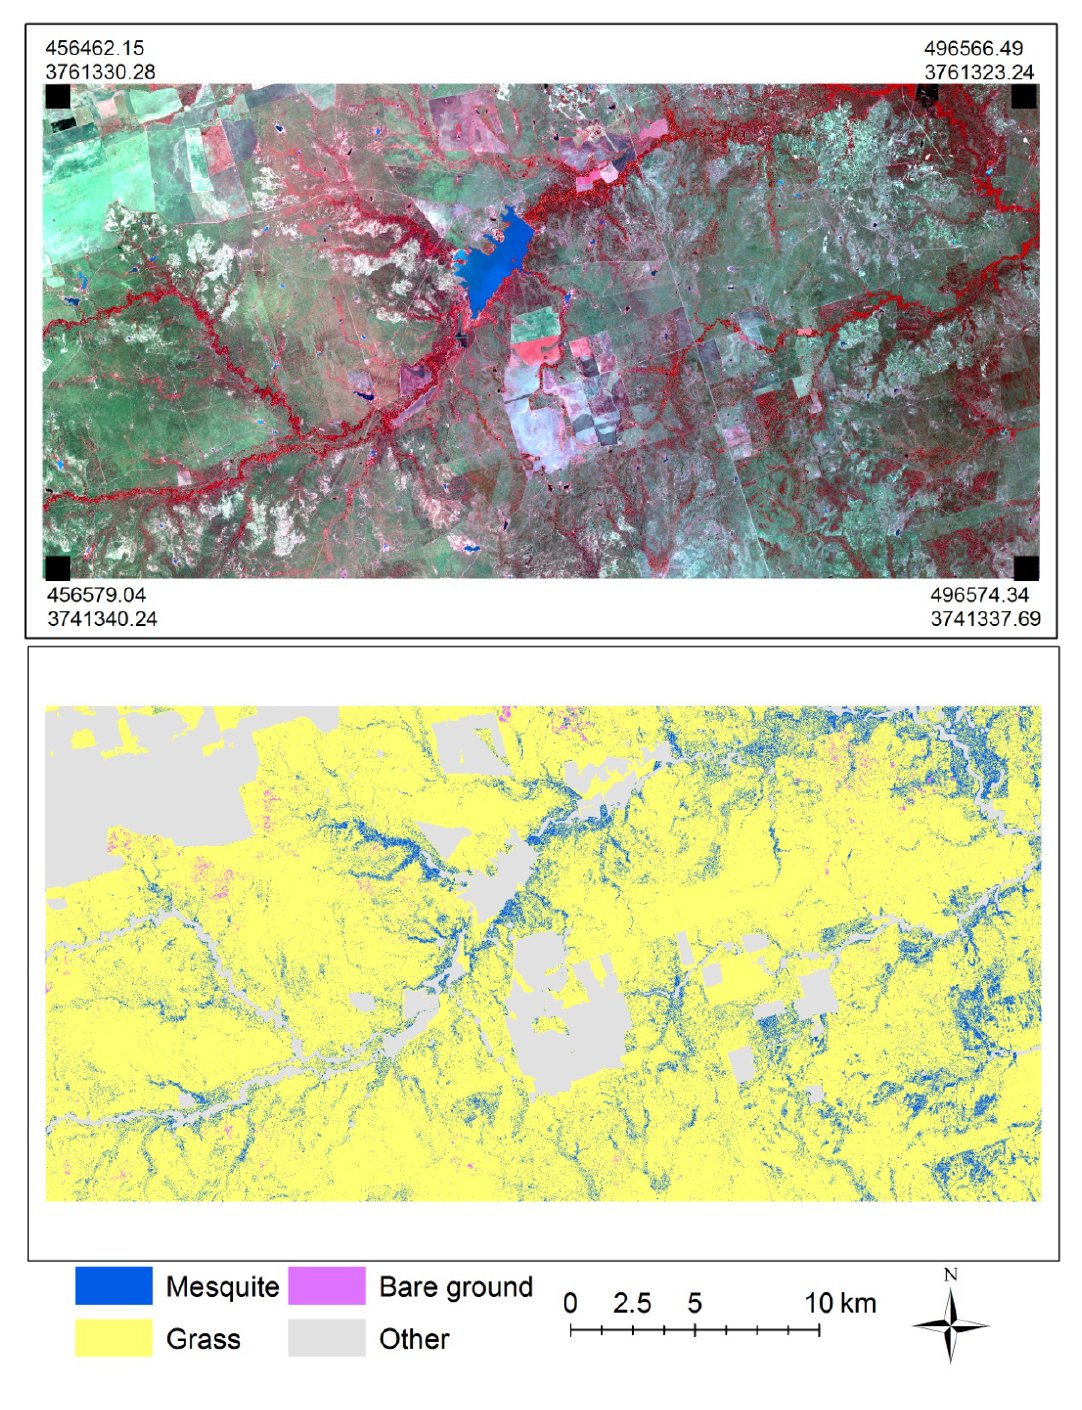
Figure 2. Color infrared National Agricultural Imagery Program imagery with 1-m spatial resolution ( top ) and classified imagery for mesquite, grass, bare ground, and other land cover types ( bottom ) over the 80,000 ha study site. Legend refers to the bottom